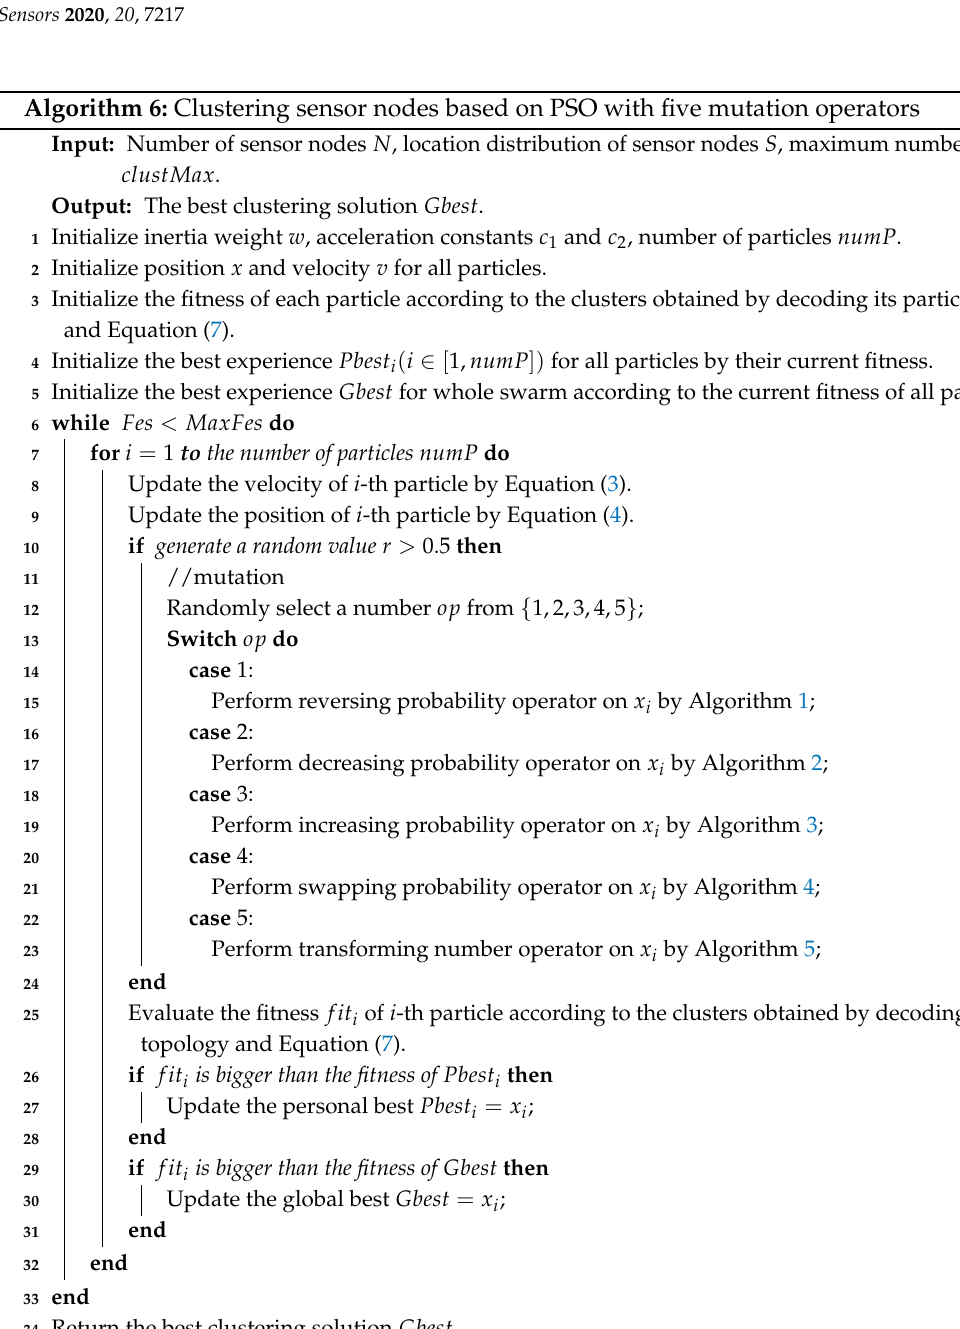
Algorithm 6: Clustering sensor nodes based on PSO with five mutation